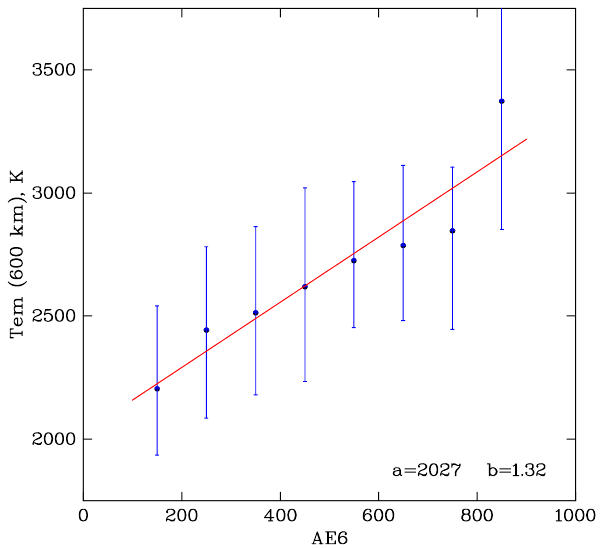
Fig. 11. Seasonal variation of the subauroral electron temperature enhancement. The format of data presentation corresponds to that of Fig. 9 except that this time only the respective regression lines are shown. These regression lines refer to winter (blue line), equinox (green line) and summer (red line)